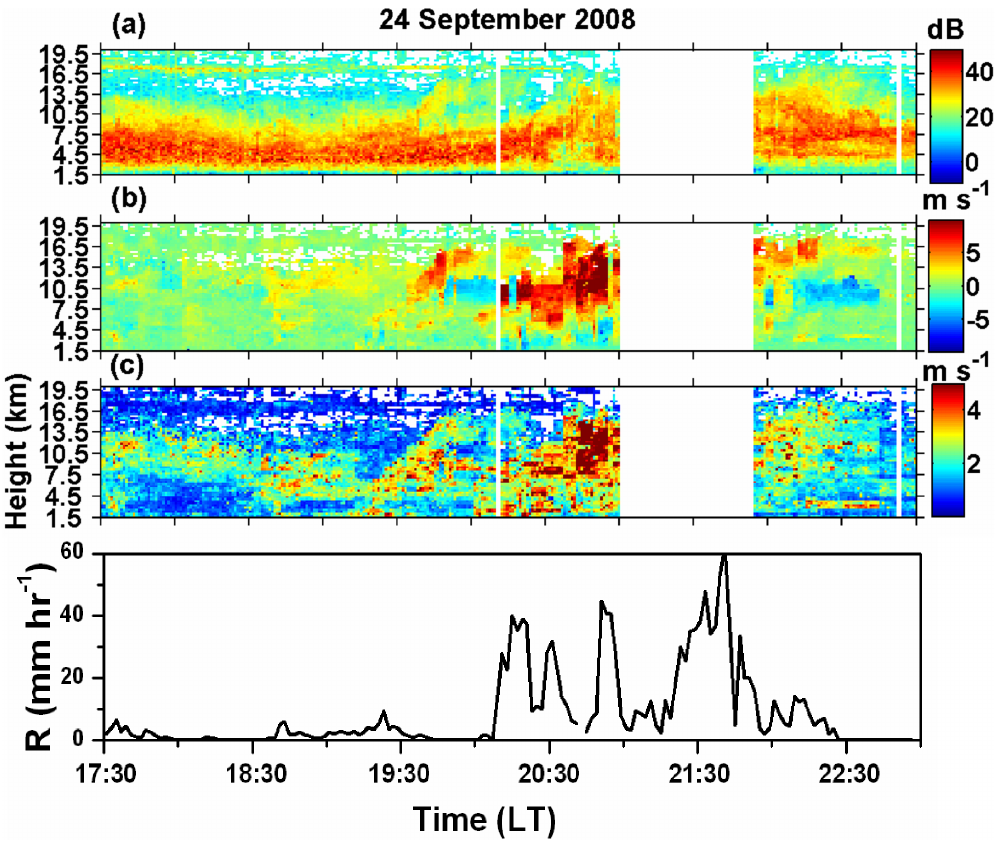
Fig. 2. Same as Fig. 1, but for 24 September